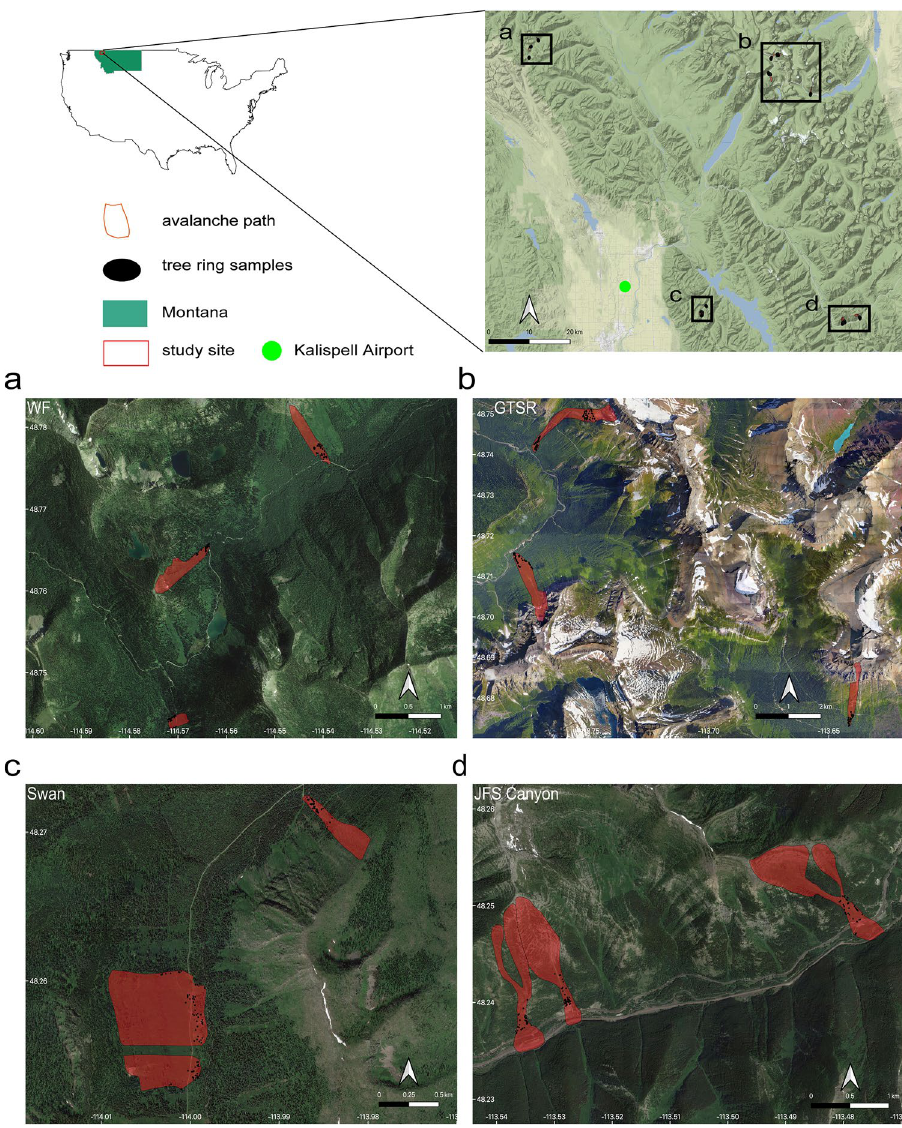
Figure 1. Study site. The red rectangle in the state of Montana designates the general area of the four sampling sites. The sites from upper left working clockwise are: ( a ) Red Meadow, Whitefish Range (WF), ( b ) Going-to-the-Sun Road (GTSR), central Glacier National Park (GNP), ( c ) Lost Johnny Creek, northern Swan Range (Swan), and ( d ) John F. Stevens (JFS) Canyon, southern GNP. Black dots represent sample locations. Abbreviated names of each path are in white text adjacent to red polygons (paths). Satellite and map imagery: © Google 64 Maps produced using ggmap in R 65 .